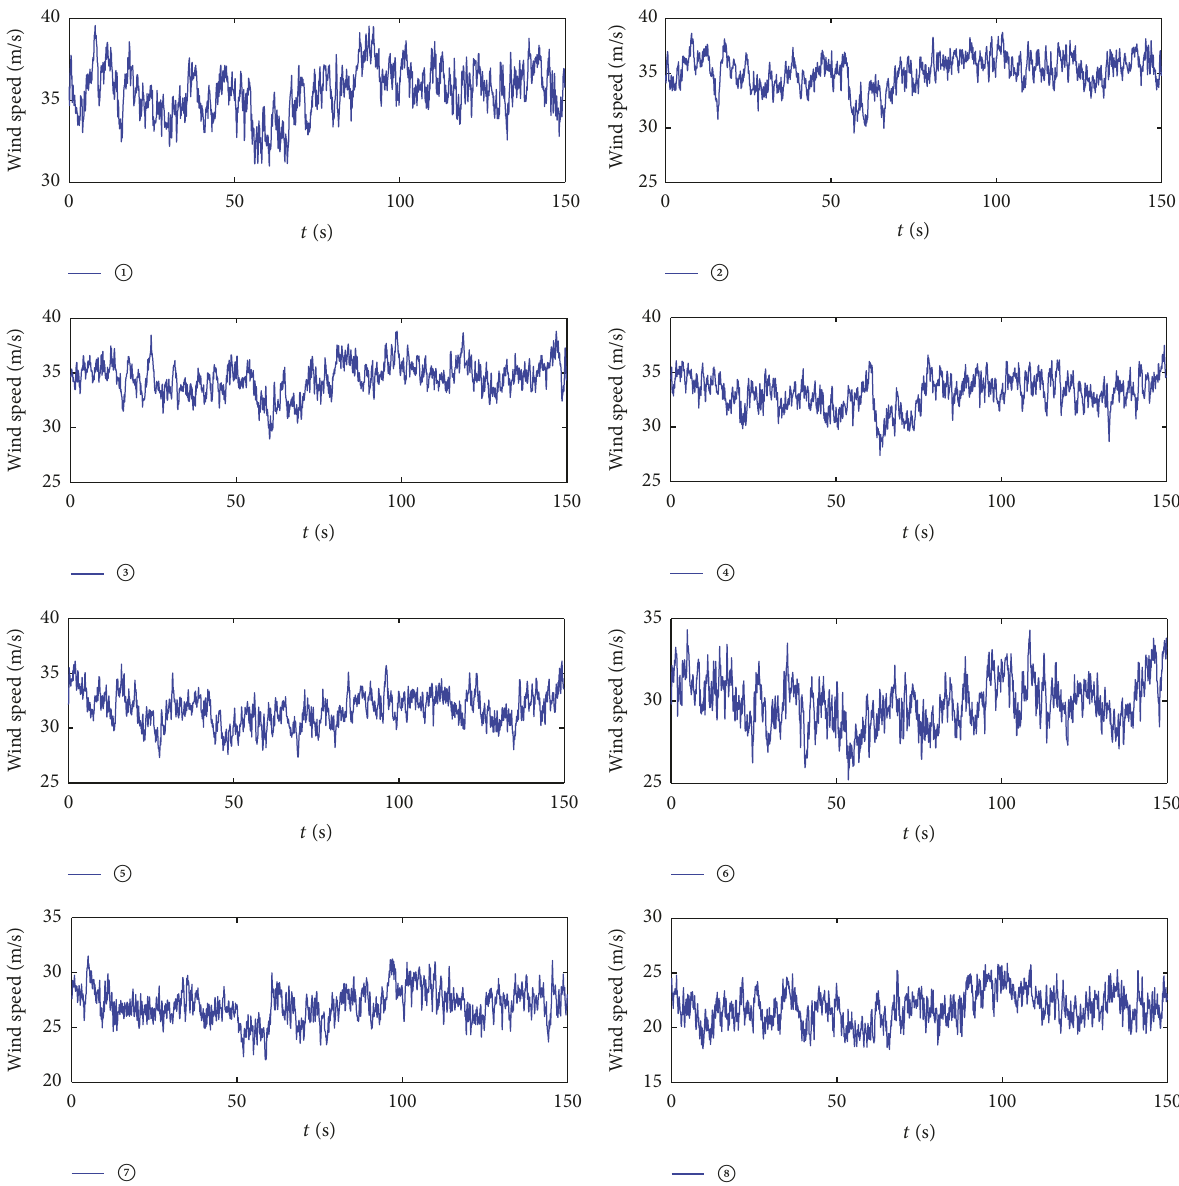
Figure 13: The simulated wind speed time history at the representative nodes on transmission tower number